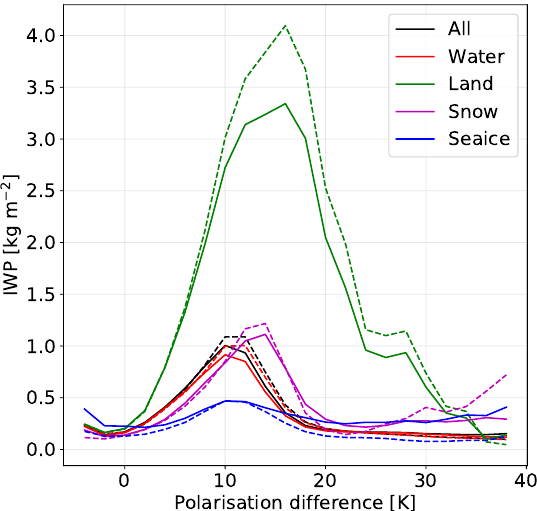
Figure 14. The average IWPs from the two retrieval datasets, binned according to the polarisation differences. Four surface types are shown. The dotted lines denote the retrievals with the TRO assumption and the solid lines represent the retrievals with the aARO